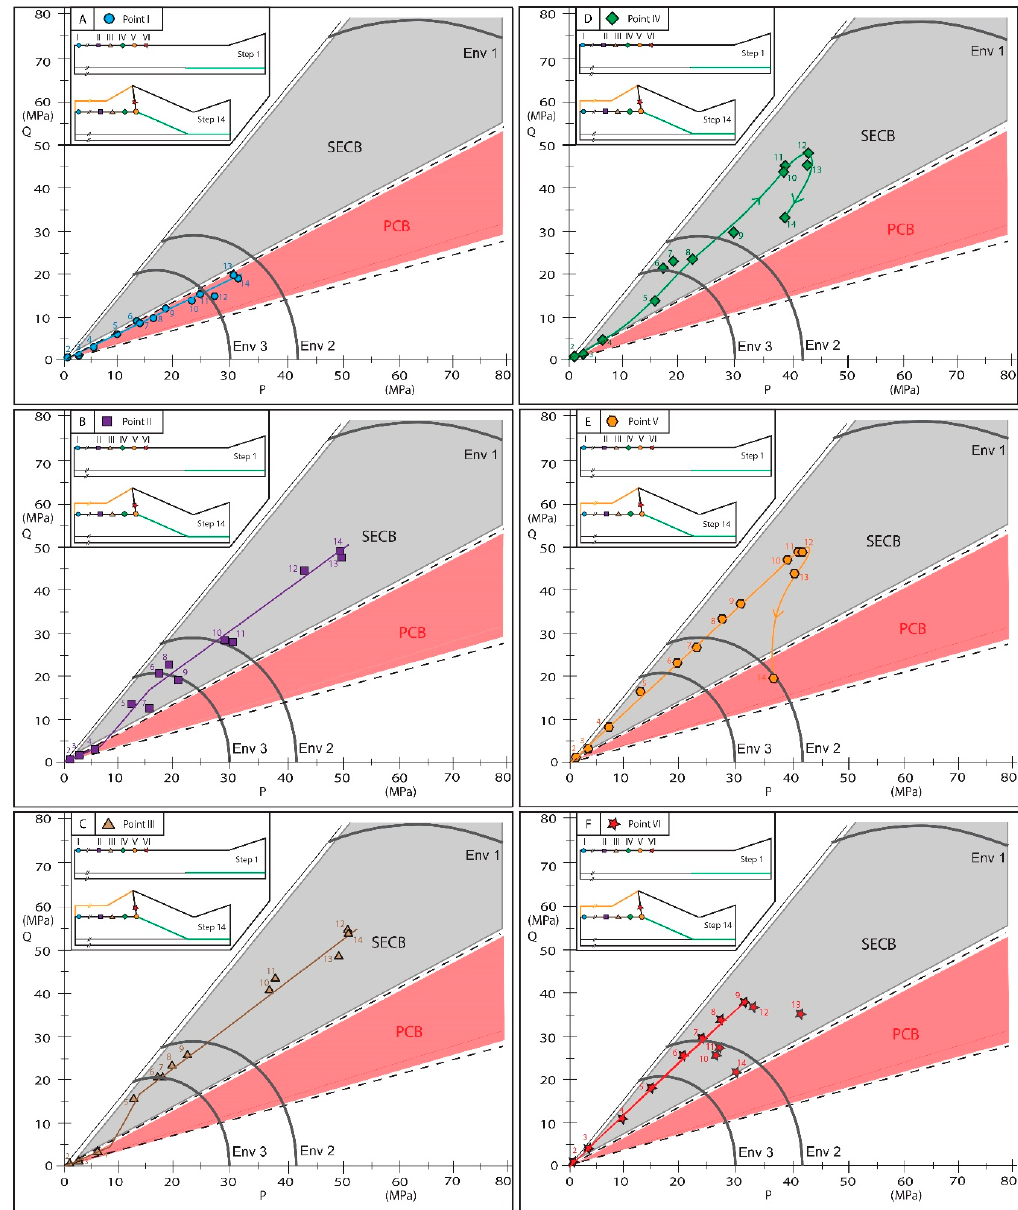
Figure 5. Stress path evolution for the different key points (See Figure 3 for point positions) in a Q-P plot from the numerical results. ( A ) Point I; ( B ) Point II; ( C ) Point III; ( D ) Point IV; ( E ) Point V; ( F ) Point VI. Stage numbers are indicated next to the points. Three yield envelopes are represented. “Env 1” represents the empirical value of the calcarenite formation with P* = 116 MPa (see text for details); “Env 2” corresponds to the Boise II sandstone with P* = 42 MPa [14]; and “Env 3” corresponds to the theoretical envelope of the calcarenite proposed by Robert et al. [24], with P* = 30 MPa. The six selected key points are presented from the farthest from the fold (blue circles numbered